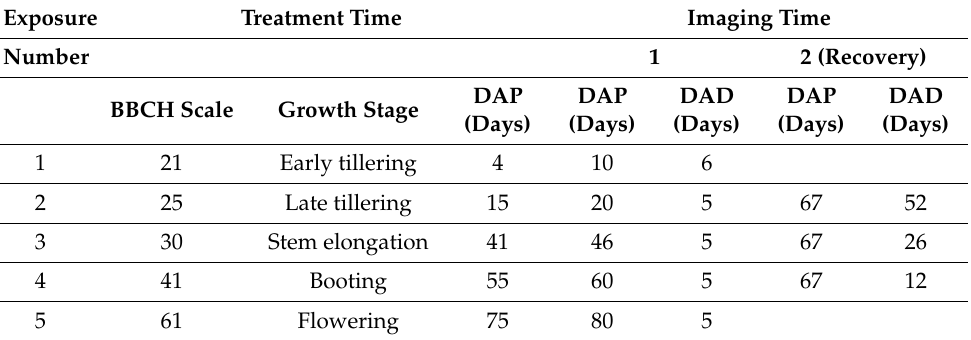
Table 1. Toluene vapor exposure simulation and UAV multispectral imagery acquisition periods presented as days after planting (DAP) and days after damage (DAD). The first multispectral capture was for damage assessment, and the second was for recovery assessment.